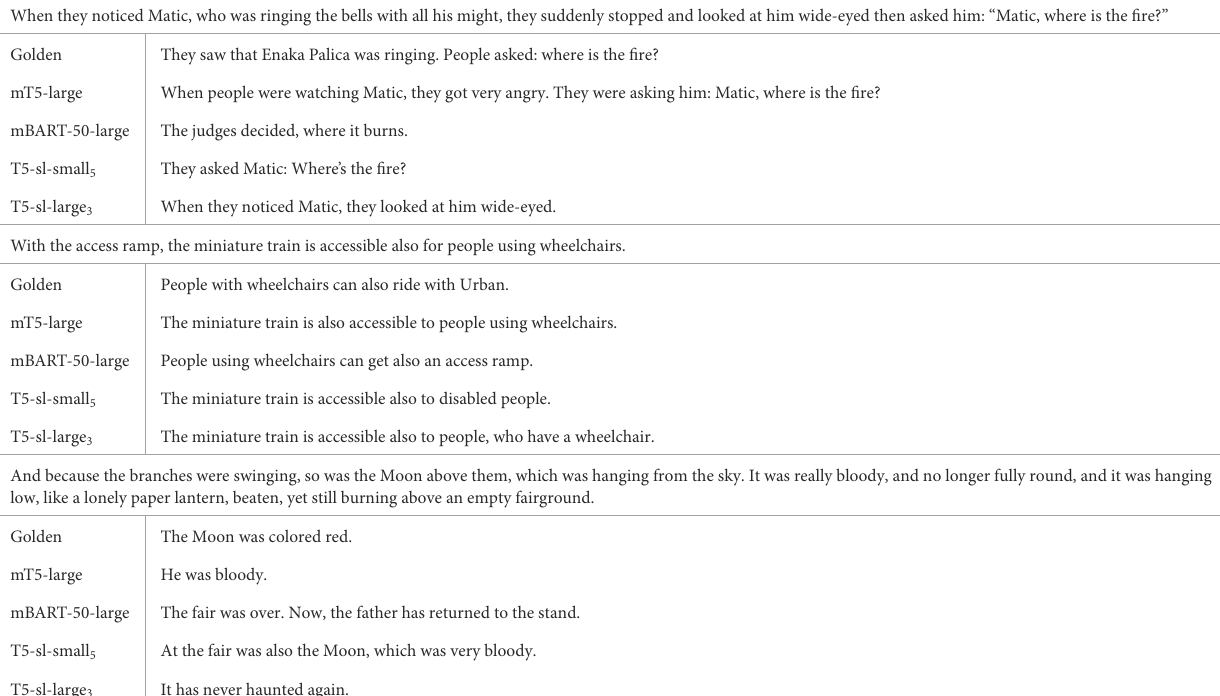
TABLE 6 Examples of generated simplified sentences on the text simplification task for the best performing models, translated into English. When they noticed Matic, who was ringing the bells with all his might, they suddenly stopped and looked at him wide-eyed then asked him: “Matic, where is the